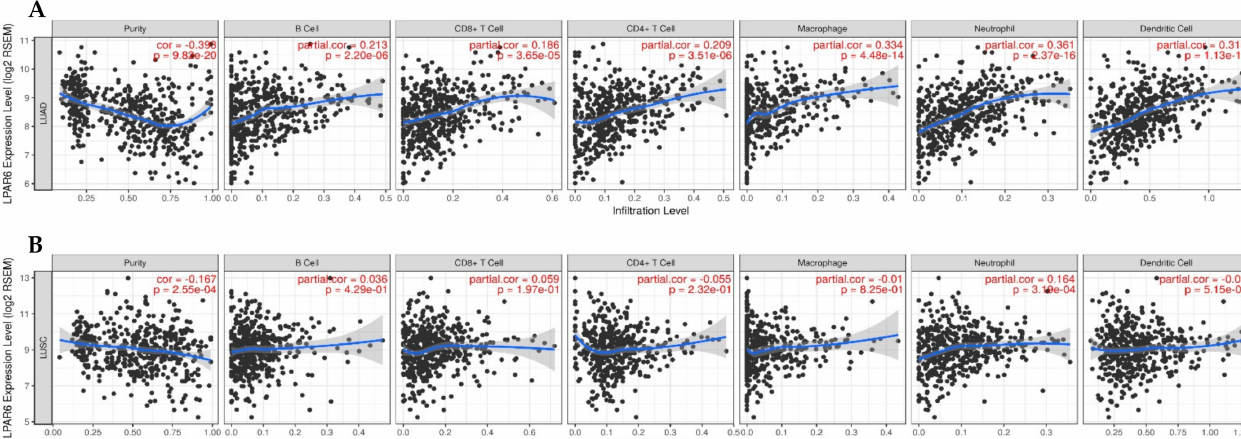
Figure 5. Correlation of LPAR6 expression with immune infiltration level in ( A ) LUAD, ( B ) LUSC. ( A ) LPAR6 expression is significantly negatively related to tumor purity and has significant strong positive correlations with the level of B cells, CD8+ T cells, macrophages, neutrophils, and DCs in LUAD ( n = 515). ( B ) LPAR6 expression is significantly negatively related to tumor purity and has weak positive correlations with infiltrating levels of neutrophils in LUSC but no significant correlation with infiltrating levels of B cells, CD8+ T cells, macrophages and DCs ( n =